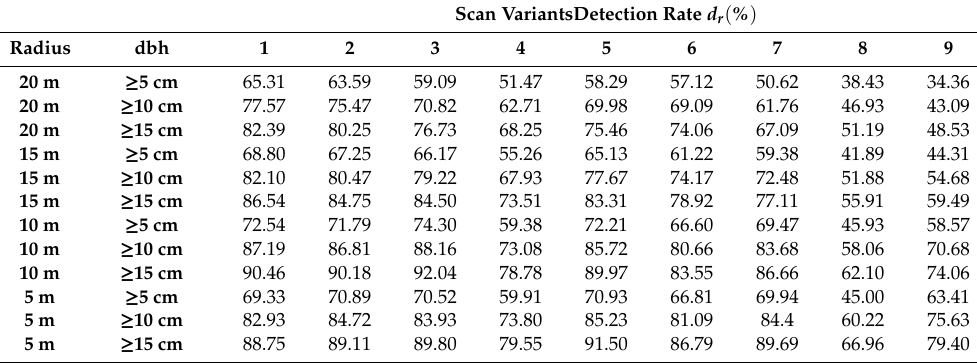
Table A3. Detection rates for di ff erent scan variants, lower dbh thresholds, and plot radii.